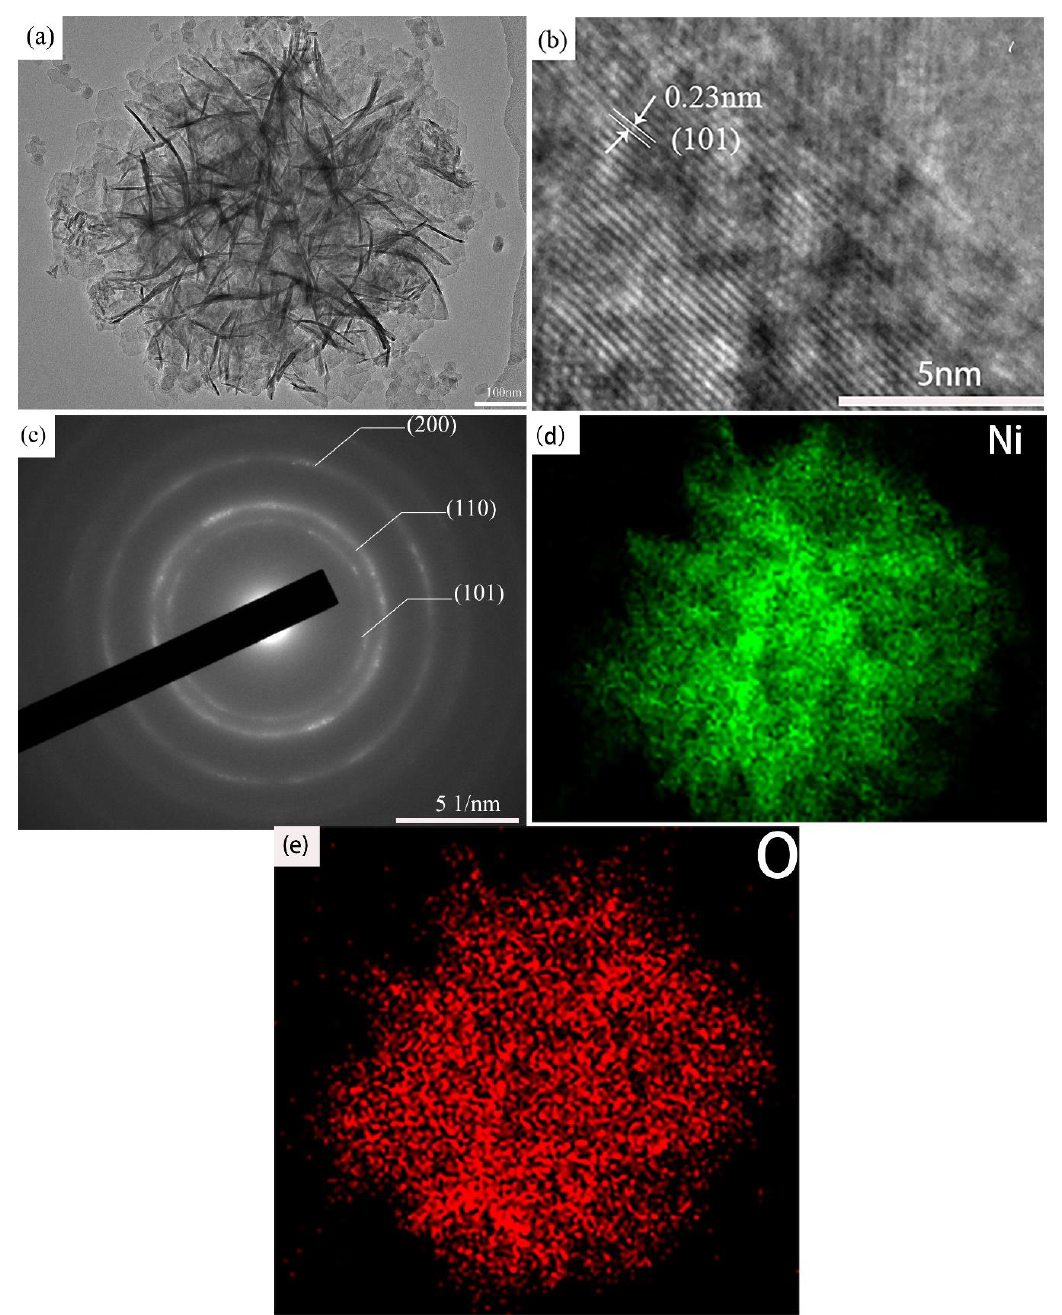
Figure 6. ( a ) TEM images of the 6 M-Ni(OH) 2 , ( b ) high resolution TEM (HRTEM), ( c ) selected area electron diffraction (SAED) and EDS mapping of ( d ) Ni and ( e ) O.